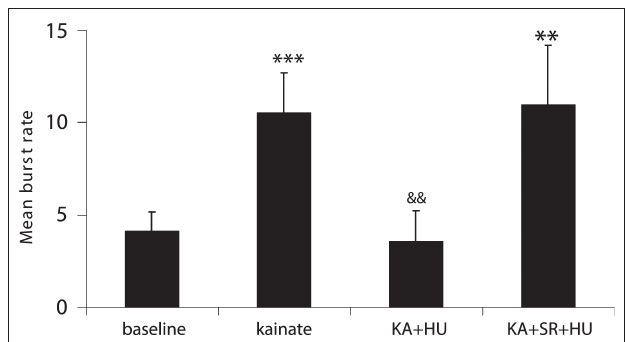
FIGURE 2 | Incidence of mean burst rate (bursts per analysis epoch ± SEM) as a function of drug treatment. KA signifi cantly increased the burst frequency from pre-drug basal activity and entrained the network to burst synchronously. Co-application of the CB1 receptor agonist HU210 (HU) signifi cantly decreased burst rate and disrupted the synchronicity in fi ring induced by KA. When injected in the presence of the CB1 receptor antagonist rimonabant (SR), HU210 did not alter KA-induced synchronous bursting activity (** p < 0.01; *** p < 0.005 vs baseline and && p < 0.01 vs KA-induced